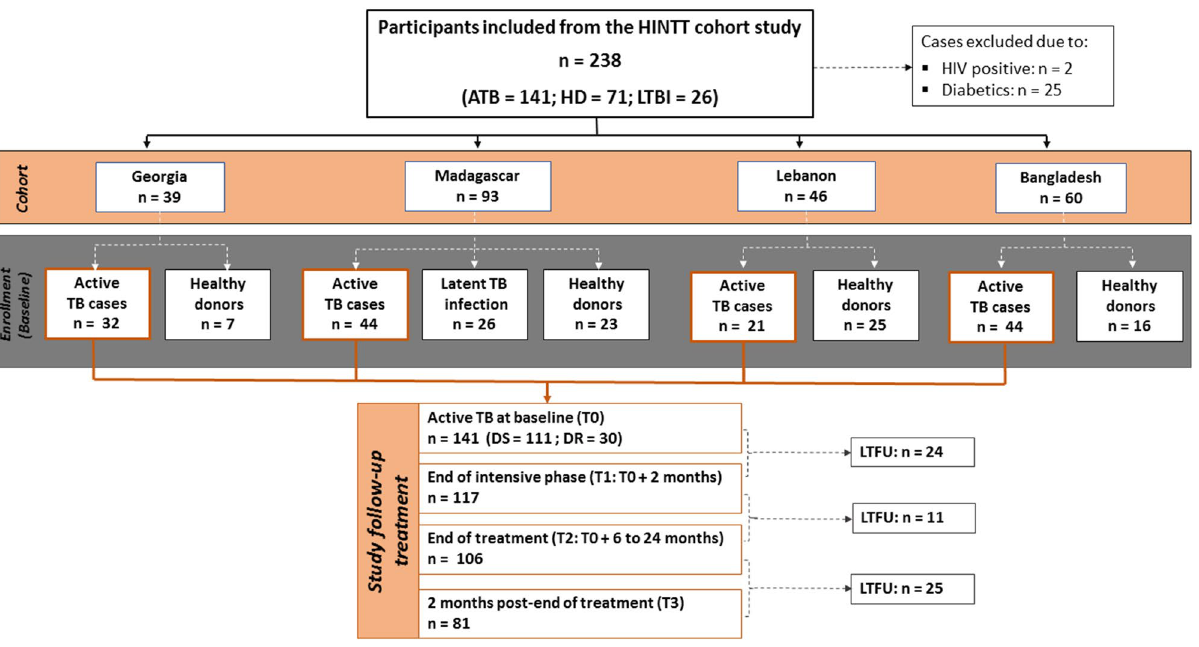
Figure 4. Flow diagram describing the enrollment and exclusion of participants with active TB, latent TB infection, and healthy donor participants from the different cohorts. ATB patients were followed-up at four different time points: at baseline (T0), ATB patients who didn’t their TB treatment and followed throughout antibiotic therapy: at month 2 (T1), at the end of treatment (T2), and 2 months after treatment completion